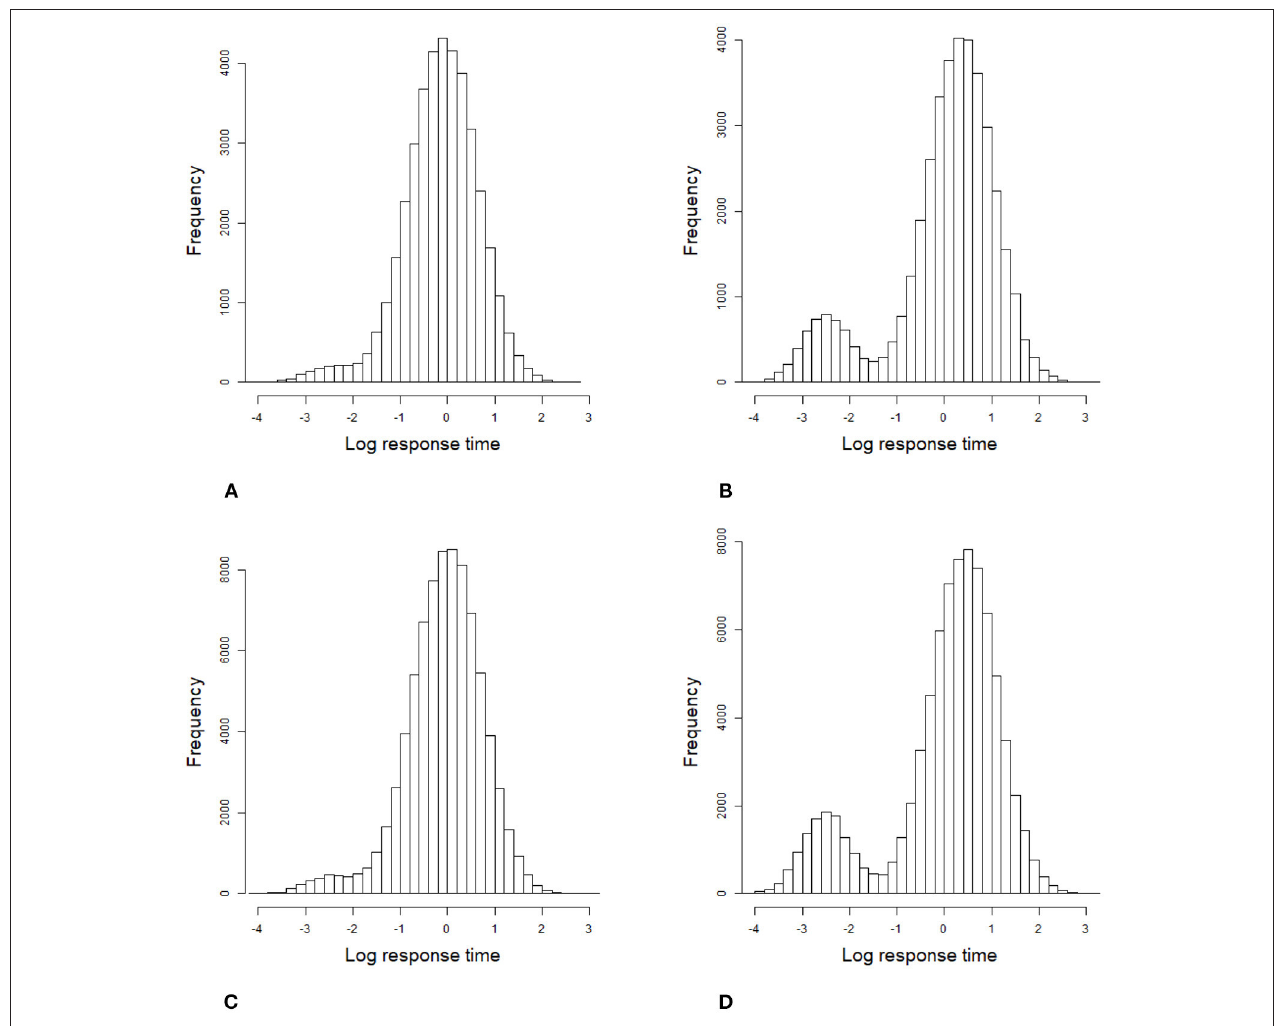
FIGURE 4 | Histogram of 2,000 examinees’ response times based on all item–person combinations in the simulation study 1. (A) items 20 and low speededness, (B) items 20 and high speededness, (C) items 40 and low speededness, and (D) items 40 and high